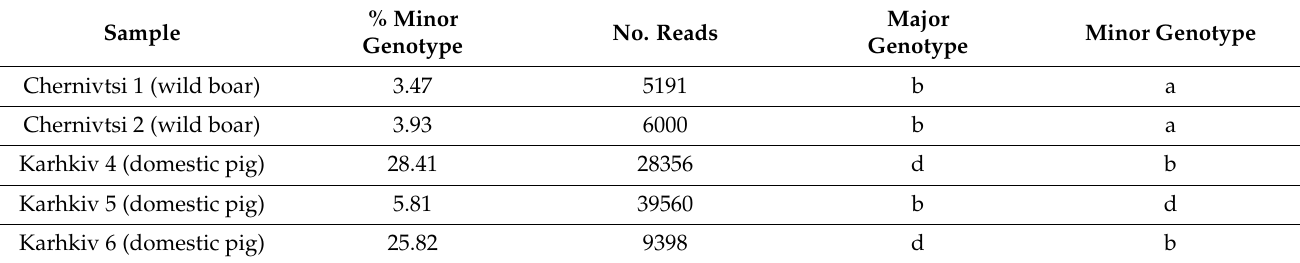
Table 3. Co-infections of two PCV2 genotypes in swine in Ukraine. Percent and number of reads binned for each minor variant in a co-infection